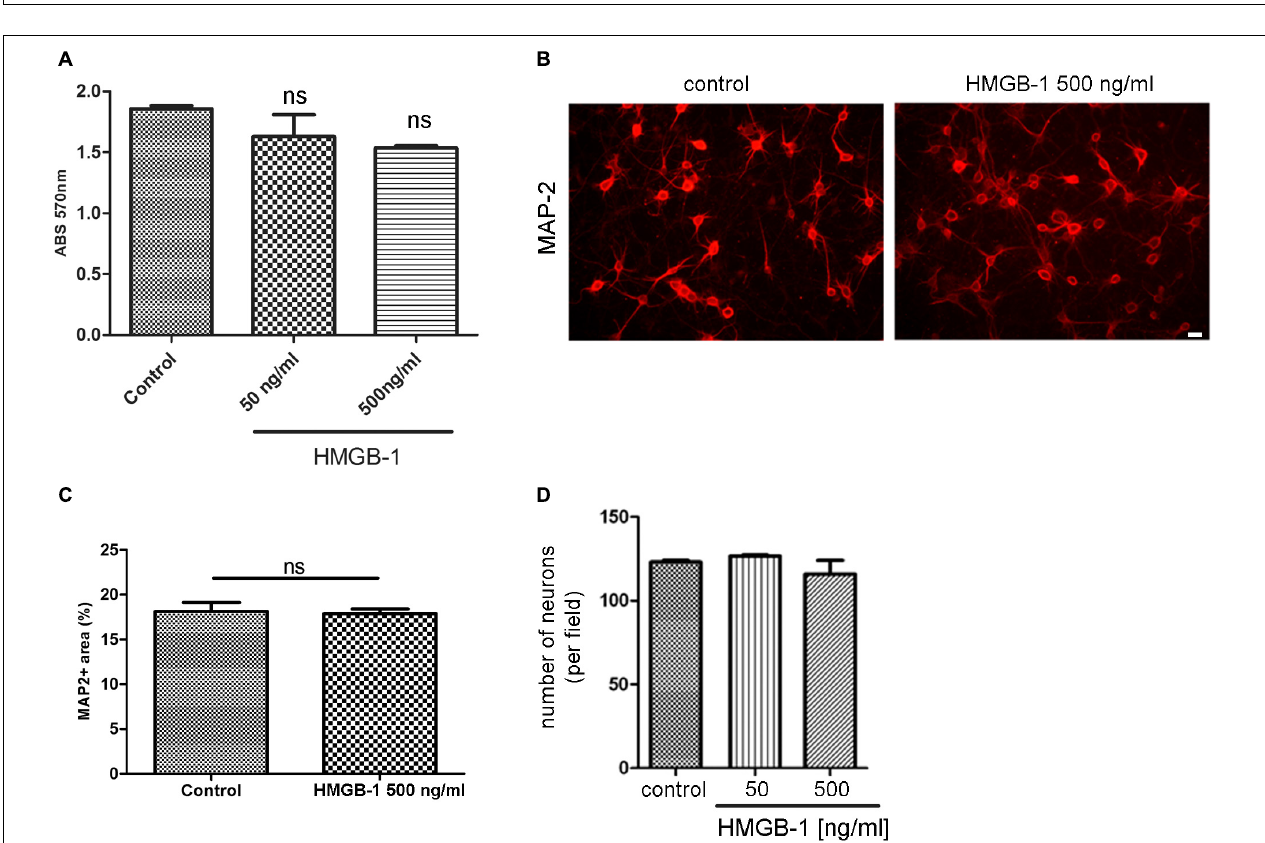
FIGURE 1 | HMGB-1 effects on hippocampal neuro-glial mixed cultures. Rat hippocampal mixed cultures (10–12 DIV) containing neurons and glial cell types were exposed to HMGB-1 for 24 h. (A) Representative images of hippocampal neuron morphology in the mixed culture identified by beta-3-tubulin immunostaining; bar = 20 µ m. (B) Quantitative analysis of neurites evaluated as the total length of neurites per neuron. (C) Quantitative analysis of the surviving neurons after 24 h of exposure to HMGB-1. The number of neurons per field was represented as the ratio of neurons vs. the total number of DAPI + nucleus per field. (D) Representative images of GFAP-immunostained astrocytes in hippocampal mixed cultures exposed to HMGB-1; bar = 15 µ m. (E) Quantitative analysis of the stellated reactive GFAP + astrocytes abundance in hippocampal mixed cultures. Stellated fibrilar GFAP + astrocytes were counted with the ImageJ plugin Cell Counter and expressed as the percent of GFAP + cells in each field. (F) Representative images of Iba-1 + microgliocytes in hippocampal mixed cultures co-stained with GFAP astrocytic cell marker; bar = 100 µ m. (G) Quantitative analysis of the microgliocytes cell abundance in the hippocampal mixed cultures showing that microglial abundance is not significantly affected by HMGB-1 exposure. Statistical analyses were performed by one way ANOVA and Student Newman–Keuls post-test, with statistical significance represented as ∗ p < 0.05, ∗∗ p < 0.01, and ∗∗∗ p < 0.001. In multiple comparisons, statistical significance against control group is shown as “a”; “aa” and “aaa” that represents p < 0.05, p < 0.01, or p < 0.001, respectively. Data presented in the graphs are mean ± SEM from three experiments.